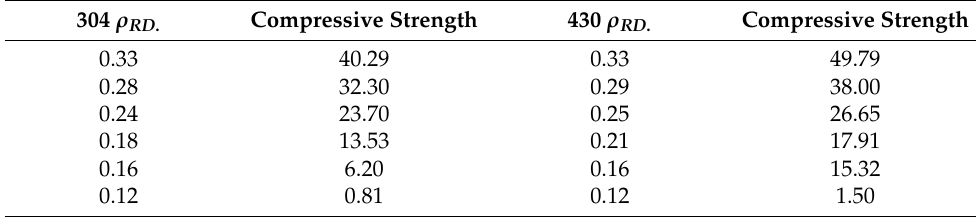
Table 2. The compressive strength of SSF samples. (MPa).